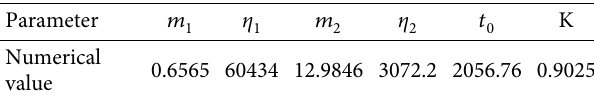
Figure 8: Failure rate of low-temperature stop valve. Table 4: Parameter calculation results based on the least square sum.